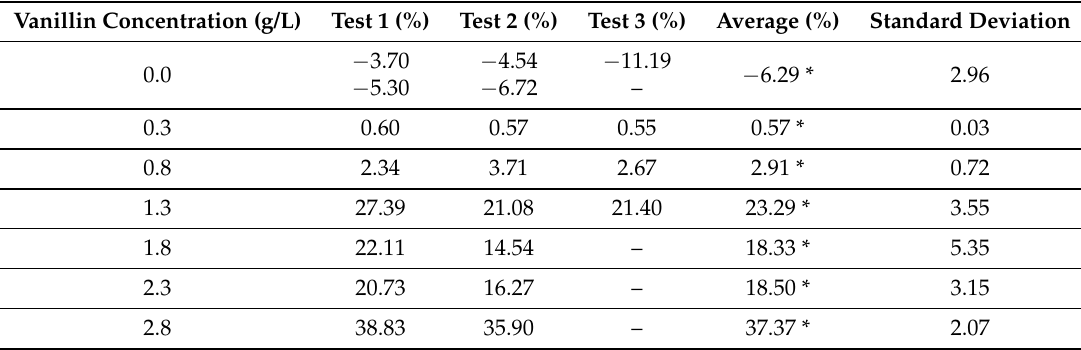
Table 3. Improvement (%) of PEG solution permeabilities after exposure of membranes to different vanillin concentrations at the pH